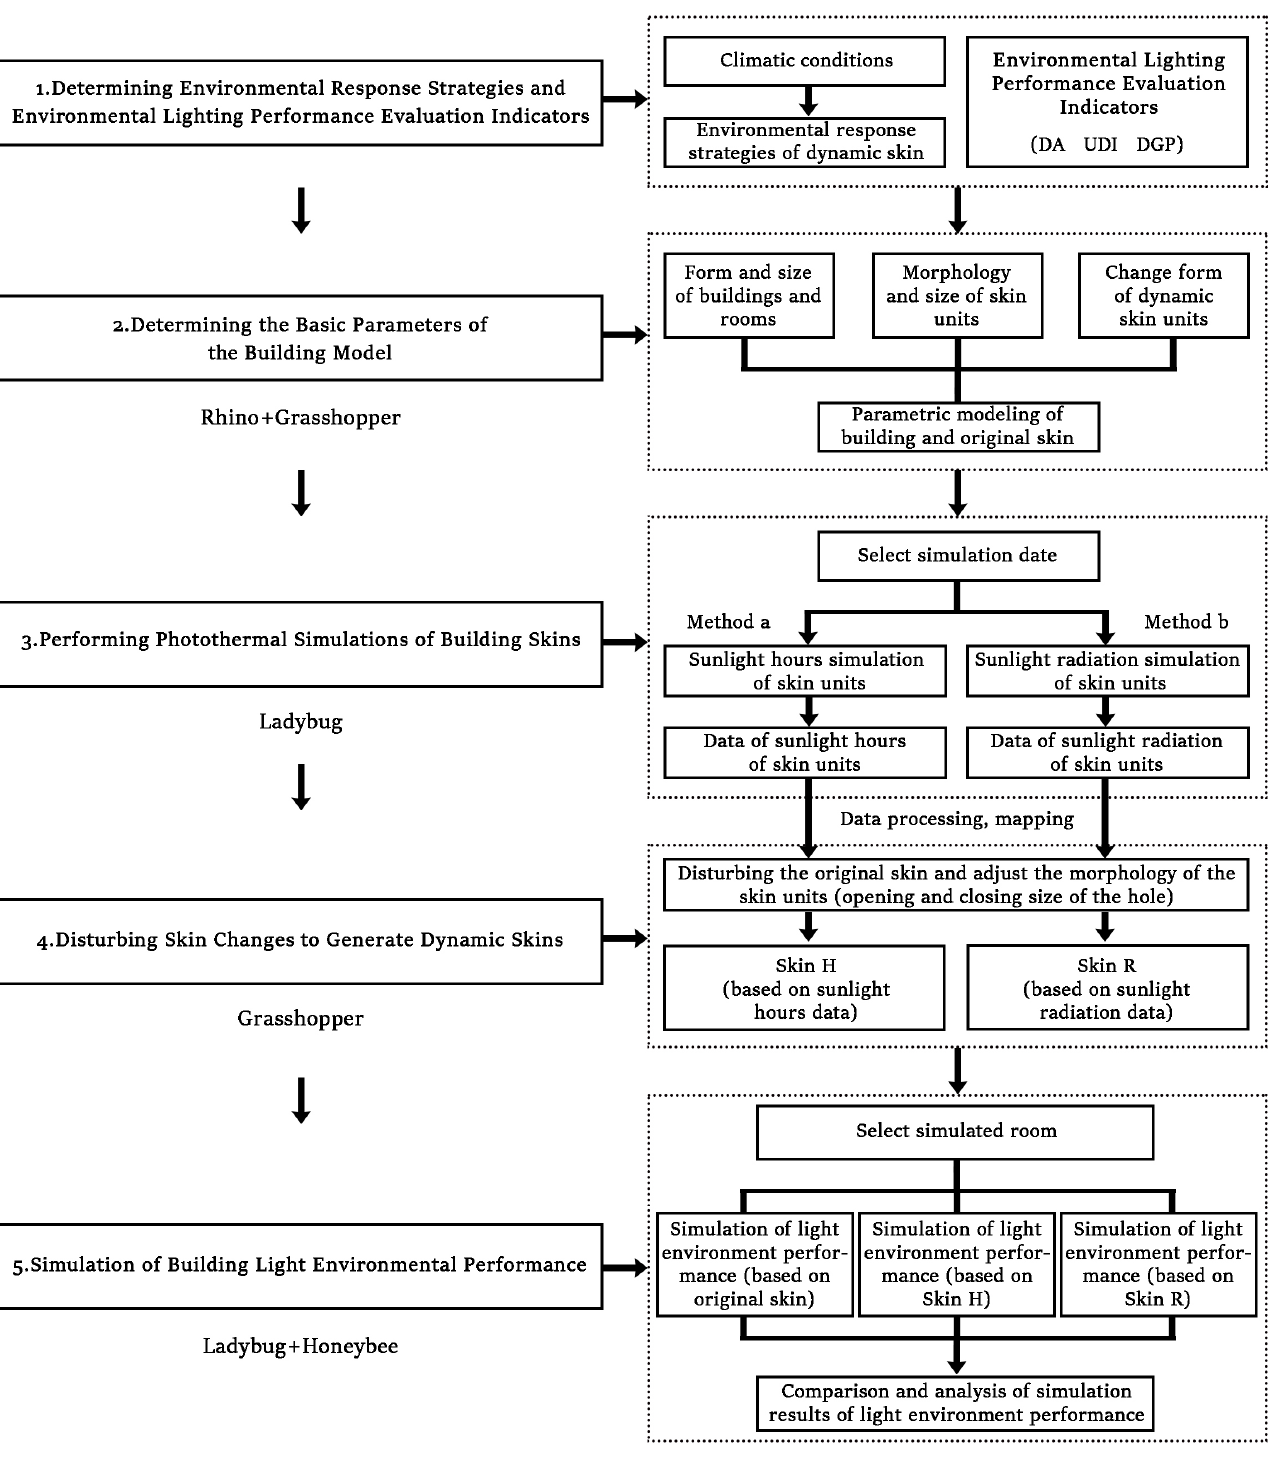
Figure 2. Parametric design method for library building light environment (self-developed).